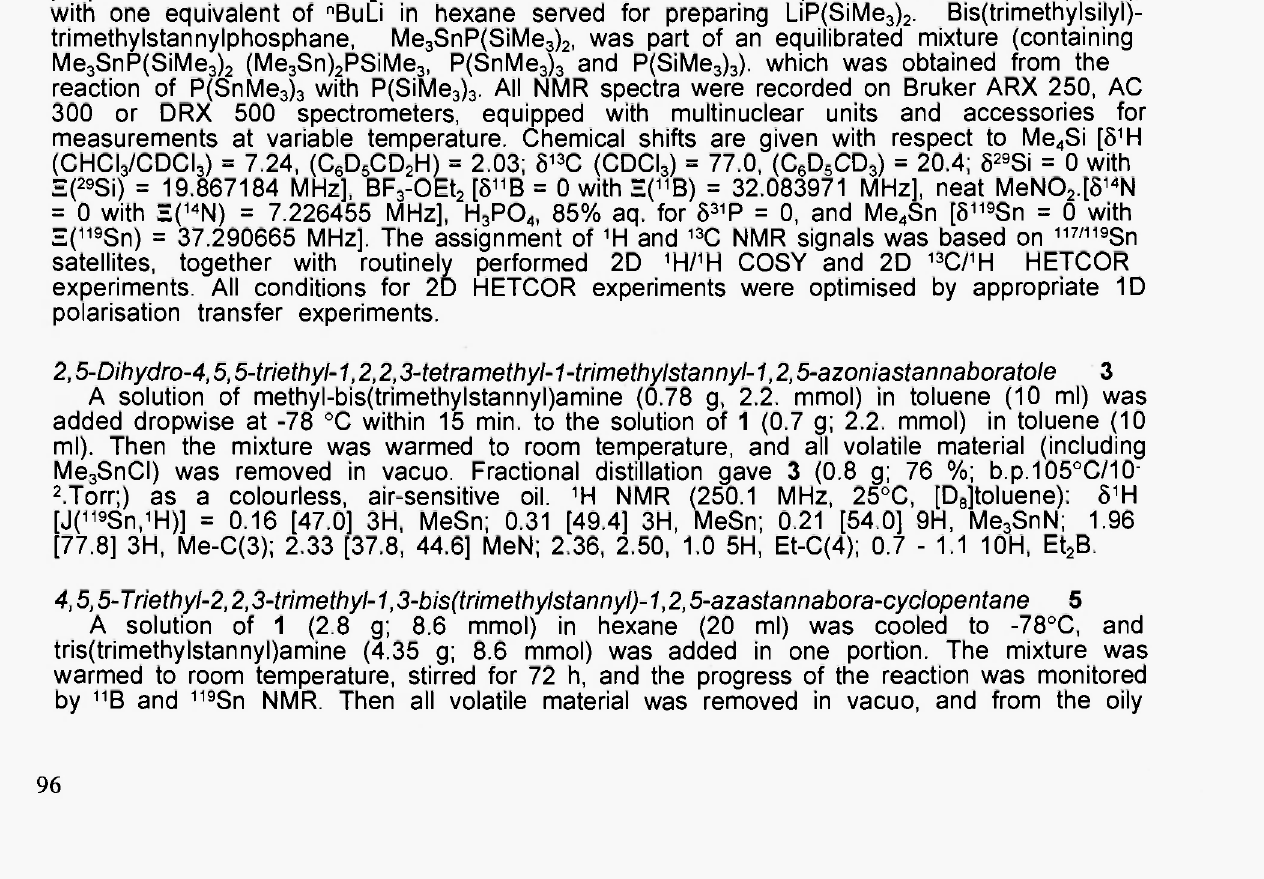
negative in 8 and